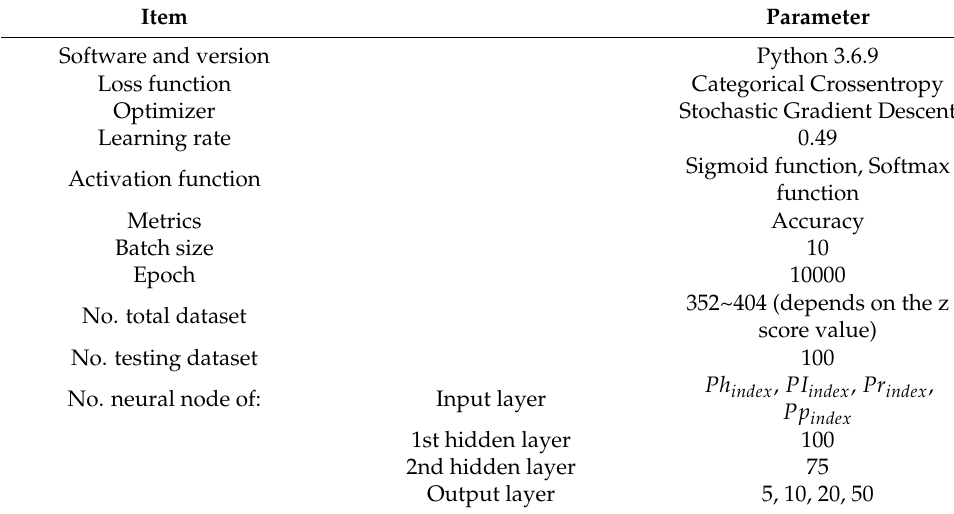
Table 5. Hyperparameters of MLP